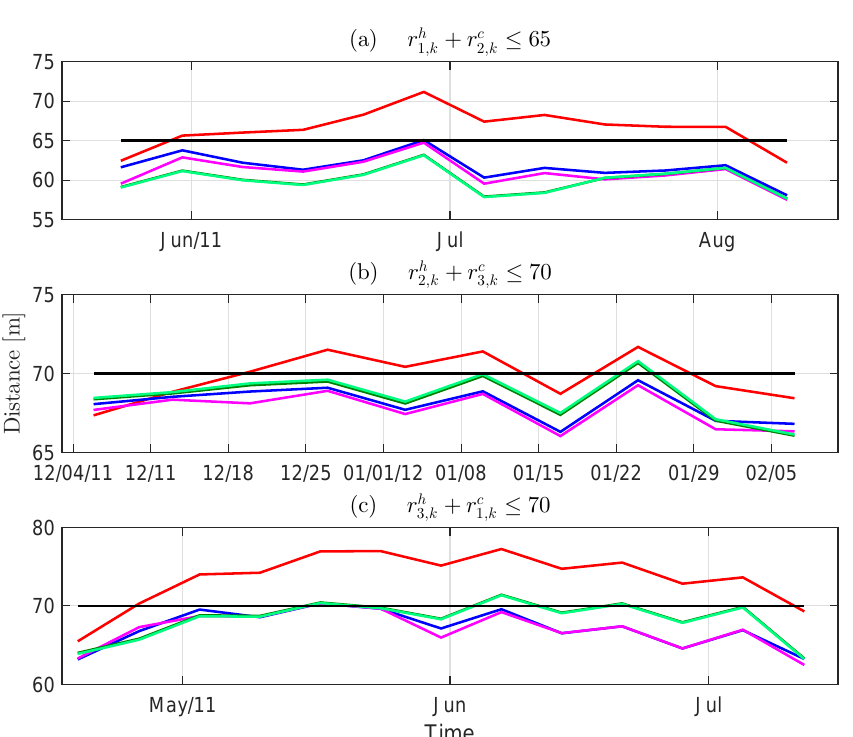
Figure 2. A-posteriori feasibility validation of the obtained results. The “red”, “blue”, “magenta”, “solid green”, and “dashed green” lines are related to the obtained results via DeSMPC, CSMPC, DSMPC, DSMPCS − 0.85, and DSMPCS − 0.50, respectively. The “black” lines are related to the upper bound